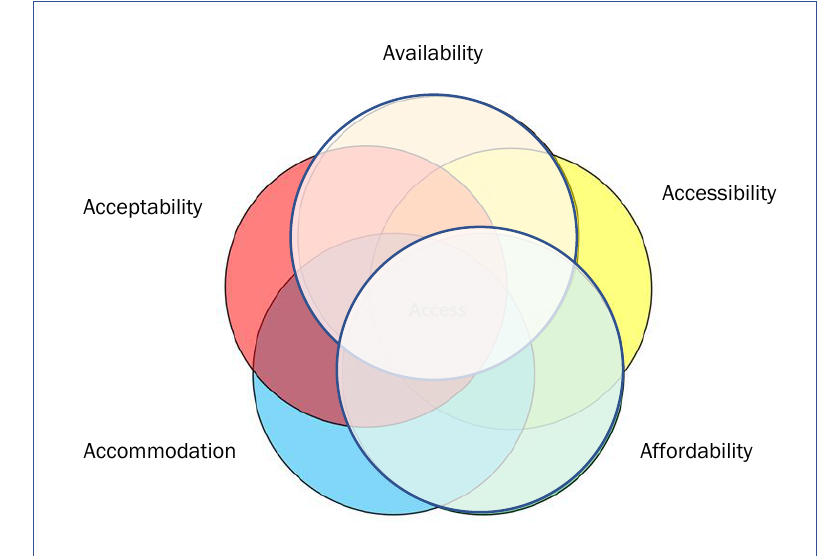
Figure 5. Limits to Access Due to State and Local